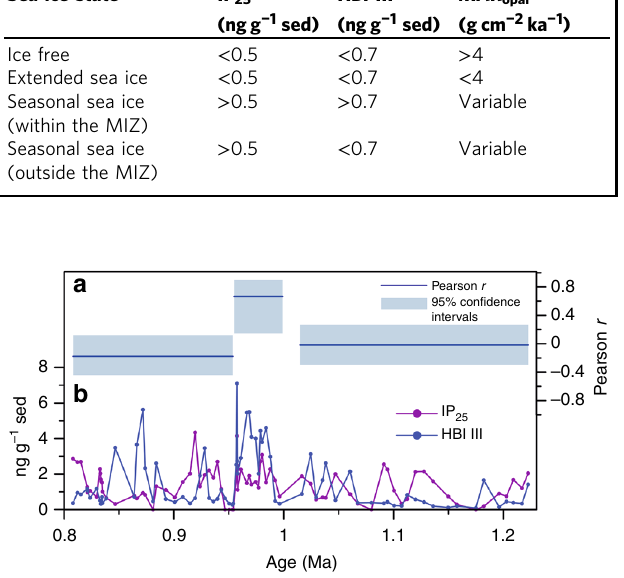
Fig. 3 Correlation of IP 25 and HBI III across the MPT interval. a Pearson ’ s r correlation coef fi cient for IP 25 and HBI III between 0.8 and 1.22 Ma, including the 95% con fi dence interval (shaded blue area), calculated using Pearson T3 66 . The interval has been divided into three subsections based on the correlation of both biomarkers, the absolute concentration and the pro fi le of sea ice increase across glacial periods. b IP 25 (violet) and HBI III (blue) concentrations from 0.8 to 1.22 Ma expressed in ng g − 1